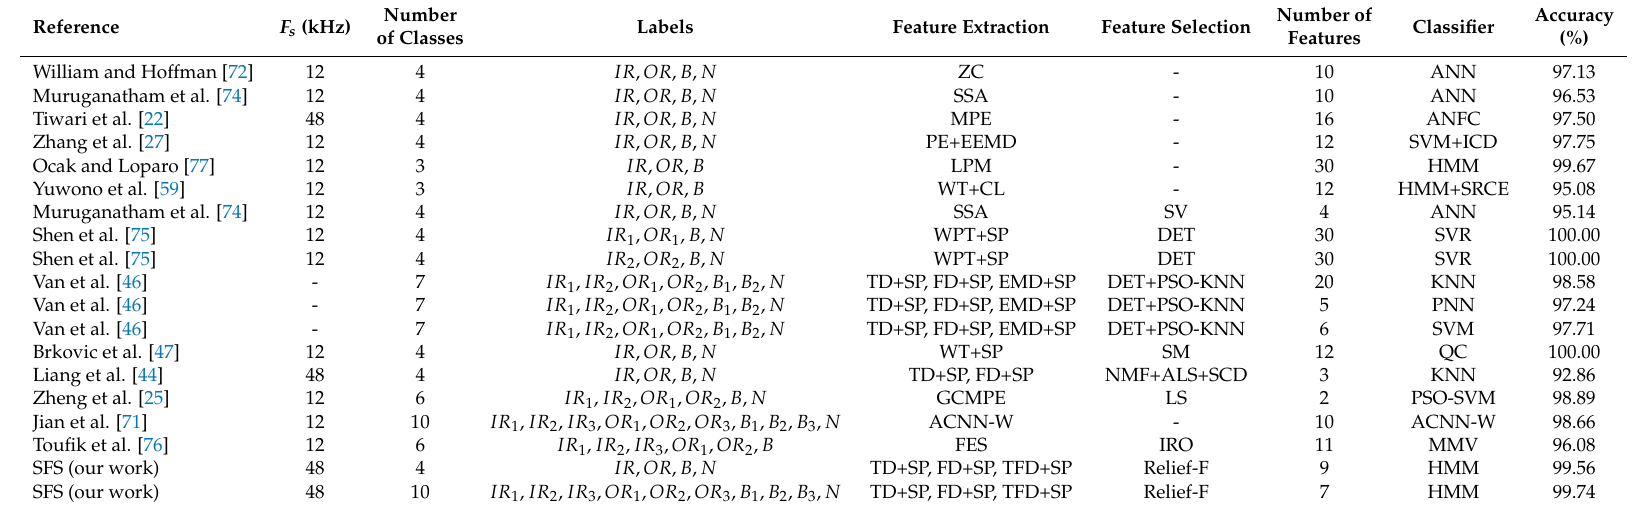
Table 6. A comparative study between current work and previous approaches published in the state-of-art for bearing fault diagnosis on the Western Case University Bearing